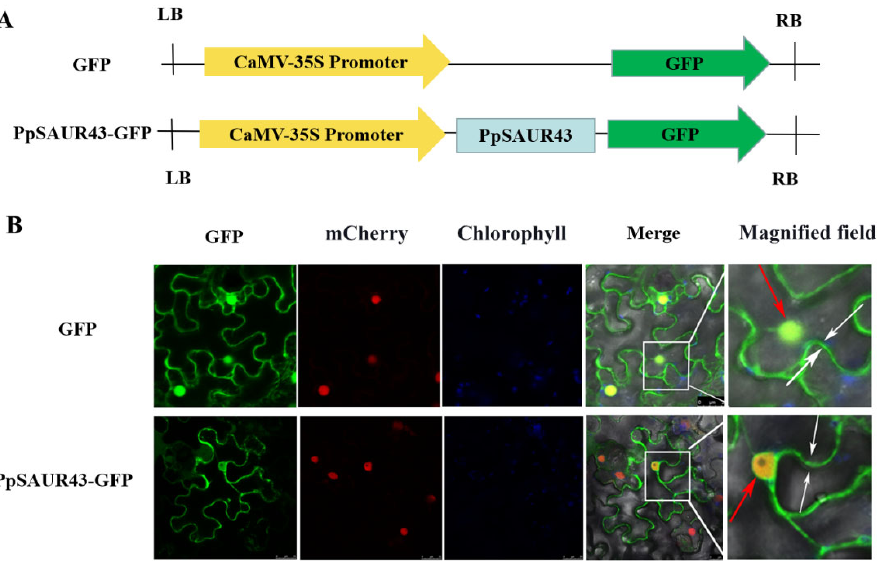
Figure 3. Subcellular localization of PpSAUR43 proteins. ( A ) Schematic diagram of GFP constructs. ( B ) Subcellular localization of proteins in Nicotiana tabacum leaf mesophyll cells. The nucleus was indicated by mCherry carrying a nuclear localization signal. The GFP fluorescence, chlorophyll autofluorescence, and mCherry were merged. The magnified field showed GFP signals in different parts of cells. White and red arrows indicate the presence of GFP signals in the cell membrane and nucleus, respectively.